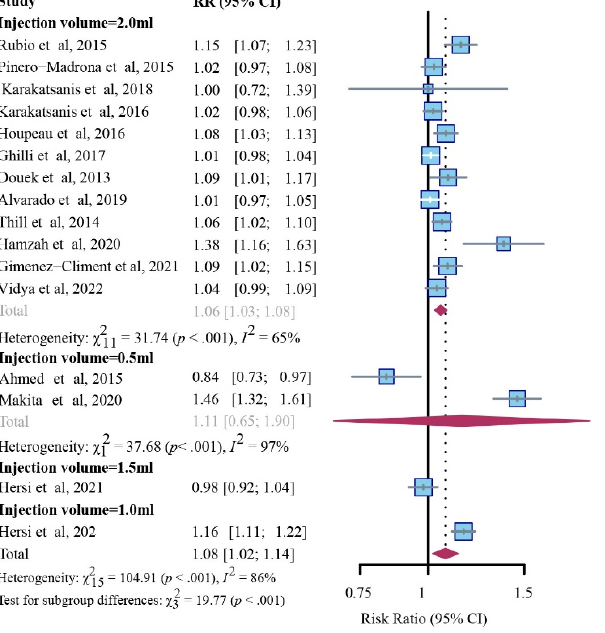
Figure 5. Subgroup analysis of SLN identification rates for SPIO versus standard method (random- effects model), stratified through baseline injection doses.